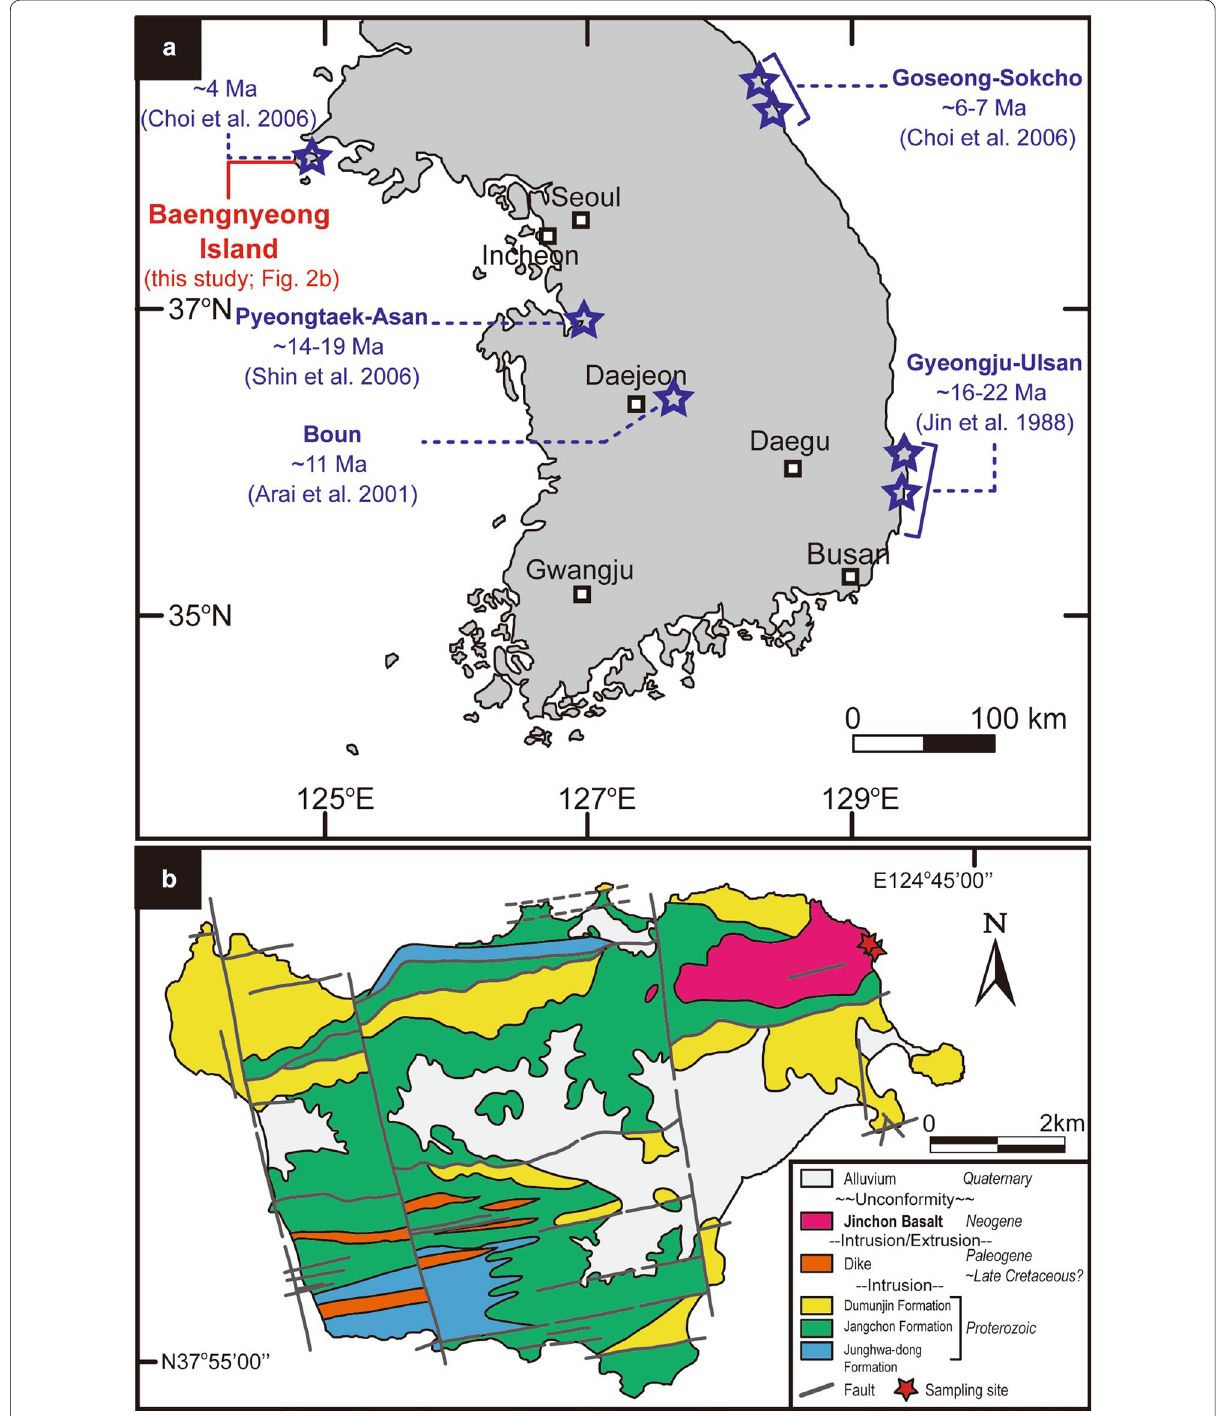
Fig. 1 Location and simplified geologic map of the studied area. a Distribution of locations of volcanic rocks with Miocene to Early Pliocene ages in South Korea, with available radiometric age estimates and their reference literatures and location of this study area (Baengnyeong Island). b Geologic map of Baengnyeong Island (after Park and Park 1996; Lim et al. 1999), with locations of our sampling sites, which belong to the Jinchon